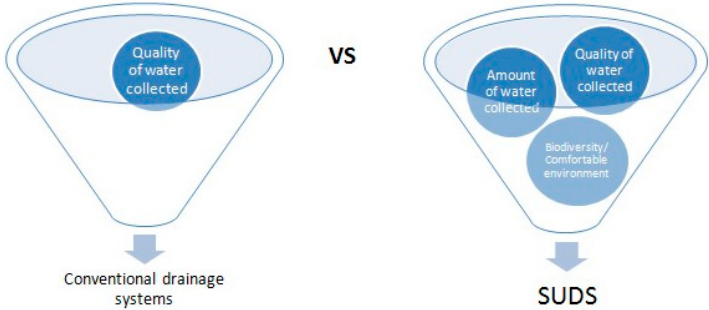
Figure 2. Comparison of conventional drainage systems and sustainable urban drainage systems (SUDS).